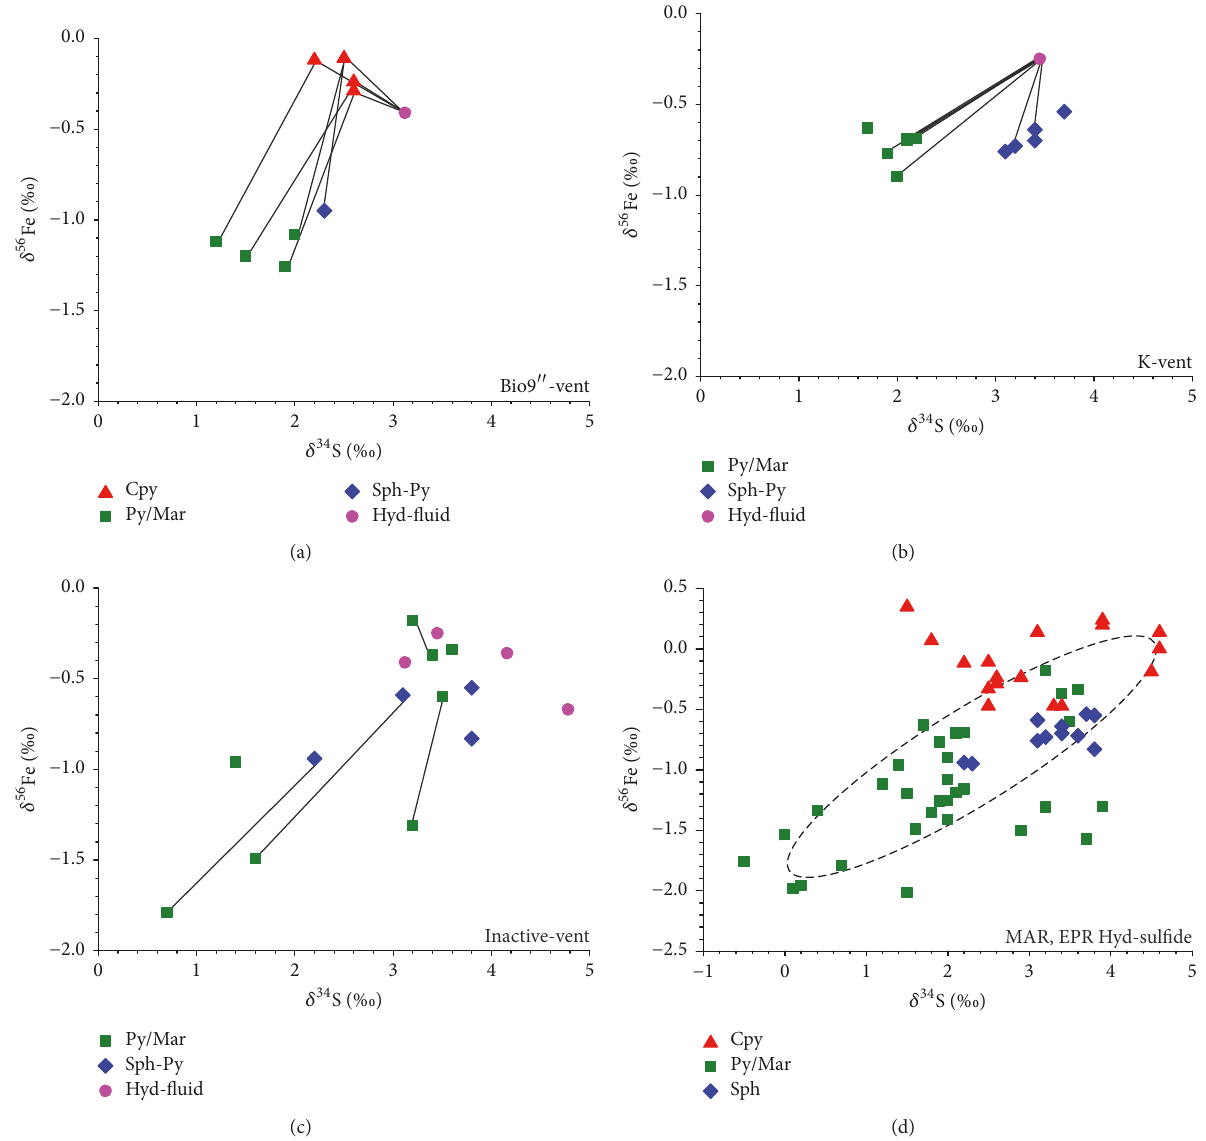
Figure 5: Plots of 𝛿 56 Fe versus 𝛿 34 S of hydrothermal vent fluids and sulfides (after [18, 19]).